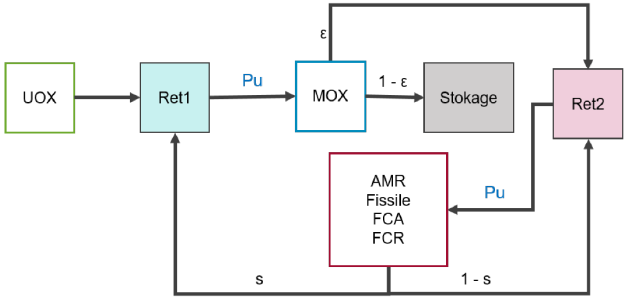
Fig. 9. Fuel cycle of a AMR - UOX - MOX fleet. Table 7. Main characteristics of the reactors featured in the UOX - MOX - AMR example.